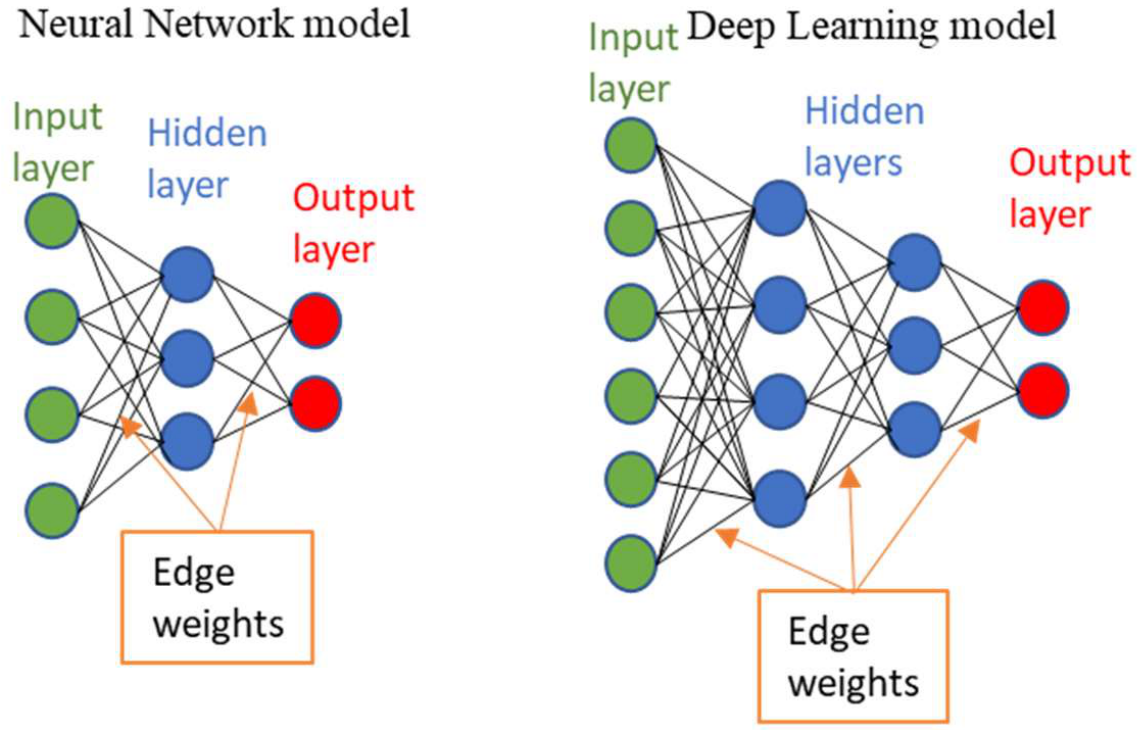
Figure 4. Neural network and deep learning model format.